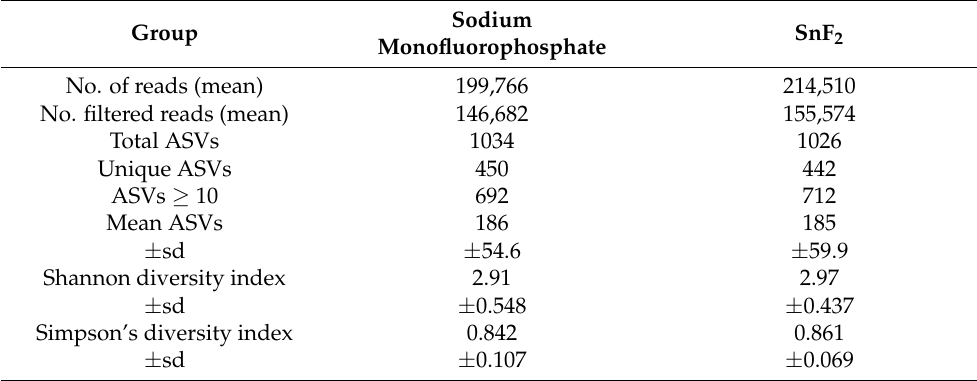
Table 1. Summary statistics of the 16S rRNA gene amplicon data.